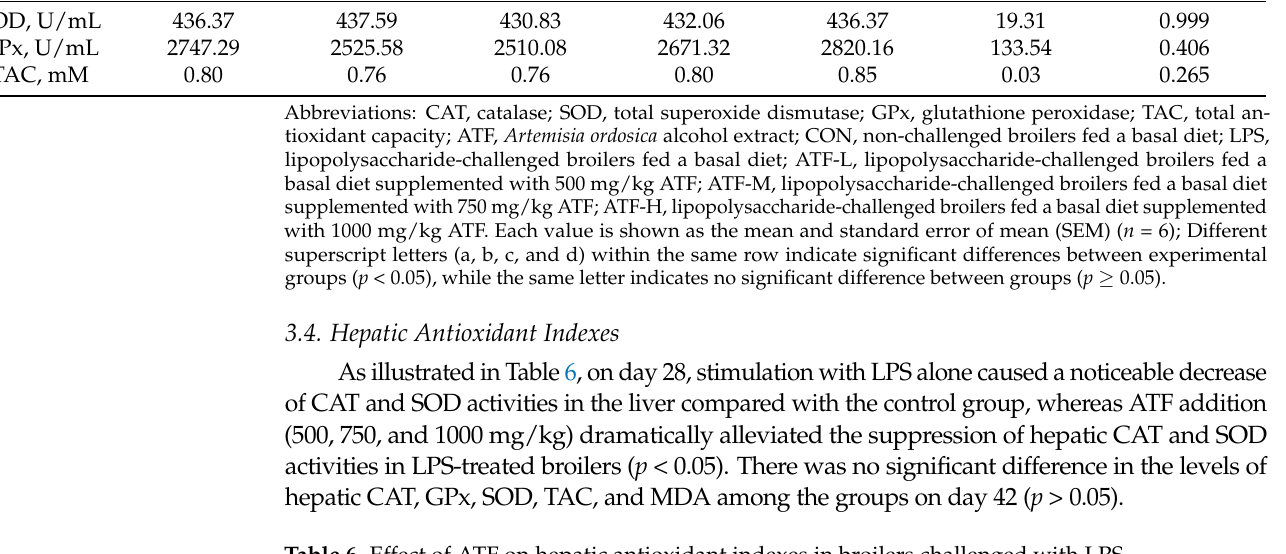
Table 6. Effect of ATF on hepatic antioxidant indexes in broilers challenged with